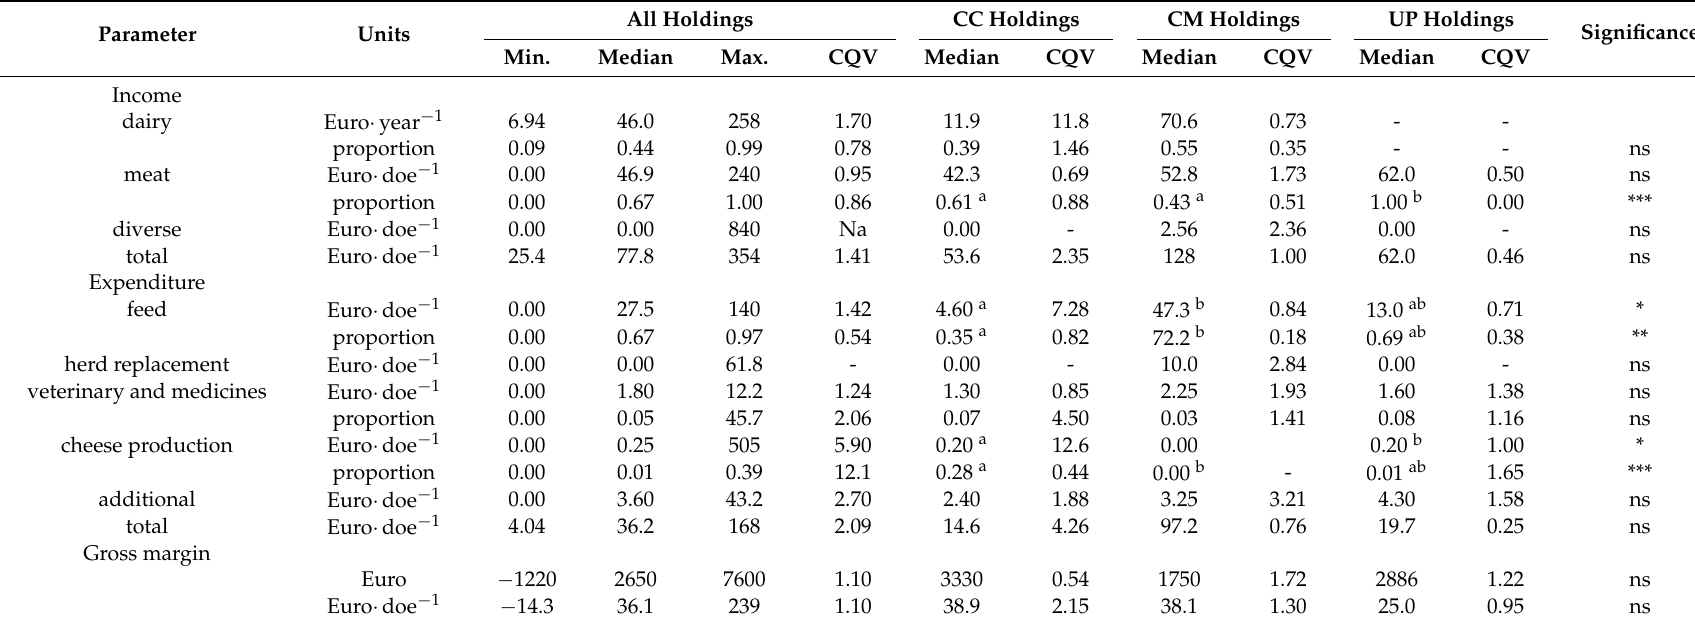
Table 8. Descriptive statistics for parameters relating to the income, expenditure and gross margin on ten goat holdings in the northern region of Morocco based on monthly data collections between September 2009 and August 2012. Holdings are classified by their dairy production status: commercial cheese (CC, n = 3), commercial milk (CM, n = 4) and undiversified (NC, n =